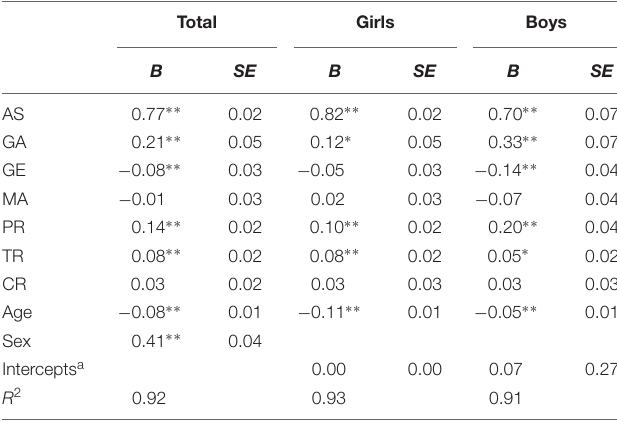
TABLE 3 | Results of regression analyses predicting self-esteem for the total sample and for girls ( n = 1323) and boys ( n = 1495).